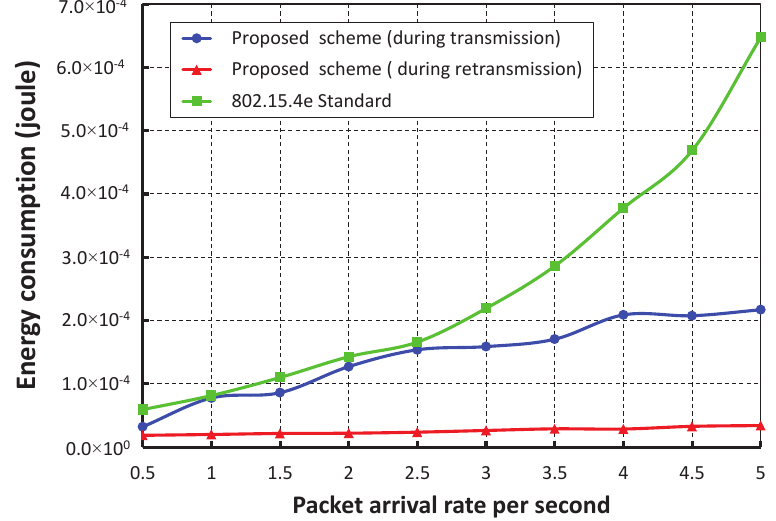
Figure 20. Comparison of the energy consumption of our proposed scheme with the IEEE 802.15.4e